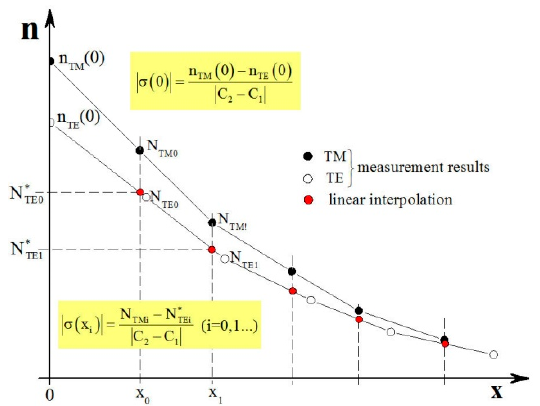
Figure 7. The method of calculating stresses based on the measurements of effective refractive indices of the modes.